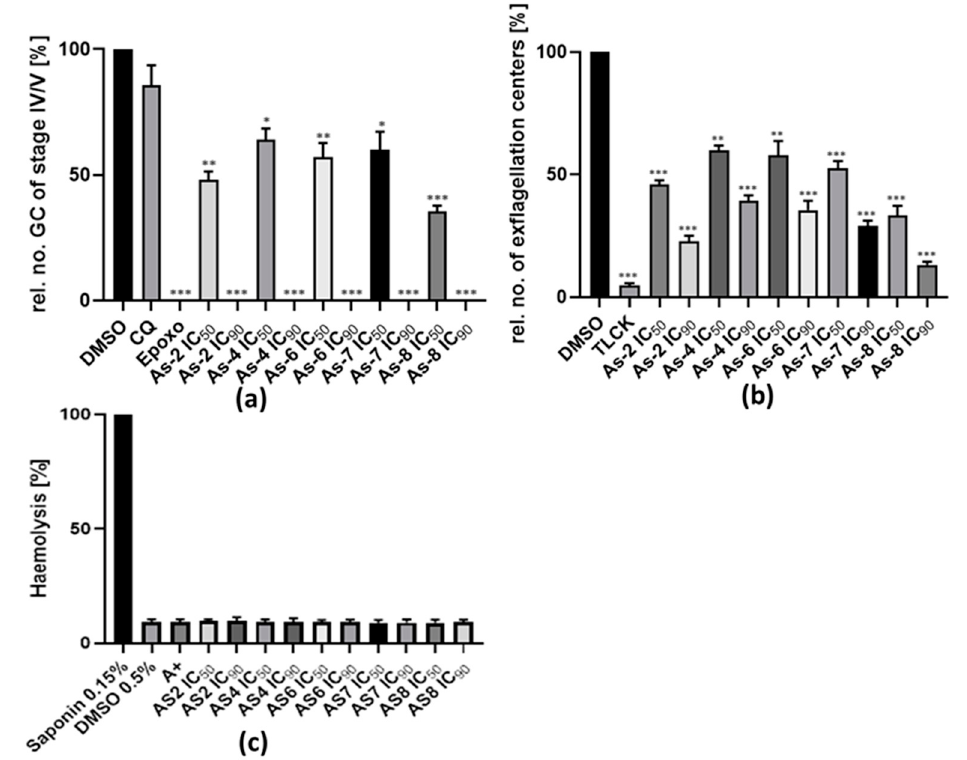
Figure 4. E ff ect of organoarsenic compounds on gametocyte development, male gametogenesis and erythrocyte viability. ( a ) E ff ect of organoarsenic compounds on gametocyte development. Stage II gametocyte-rich cultures were treated with IC 50 and IC 90 concentrations of compounds for 2 d and further cultivated for another 7 d. The numbers of stage IV and V gametocytes were counted and normalized to 0.5% v / v dimethyl sulfoxide (DMSO) treatment (set to 100%). CQ (0.25 µ M) was used as a negative control and epoxomicin (50 nM) served as a positive control. ( b ) Inhibition of exflagellation by organoarsenic compounds. Compounds at IC 50 and IC 90 concentrations were added to mature gametocyte cultures for 15 min prior to their activation with xanthurenic acid. The numbers of exflagellation centers were counted at 15 min post-activation and normalized to 0.5% v / v DMSO (set to 100%). Tosyl- l -lysyl-chloromethane hydrochloride (TLCK) (30 µ M) was used as positive control. ( c ) Hemolytic e ff ect of organoarsenic compounds. Compounds at IC 50 and IC 90 concentrations were added to fresh erythrocytes (5% hematocrit) and incubated at 37 ◦ C for 48 h. The absorbance of free hemoglobin in the supernatant was measured at OD 550 nm and normalized to 0.15% w / v saponin (set to 100%), which was used as positive control in the experiments. The 0.5% DMSO and A + medium served as a negative control. The graphs represent the results of three to four independent experiments performed in triplicate (mean ± SEM; standard error of mean). Asterisks represent a significant di ff erence between the tested compounds and DMSO control, *** p < 0.001; ** p < 0.01; * p < 0.05 (student’s t-test).